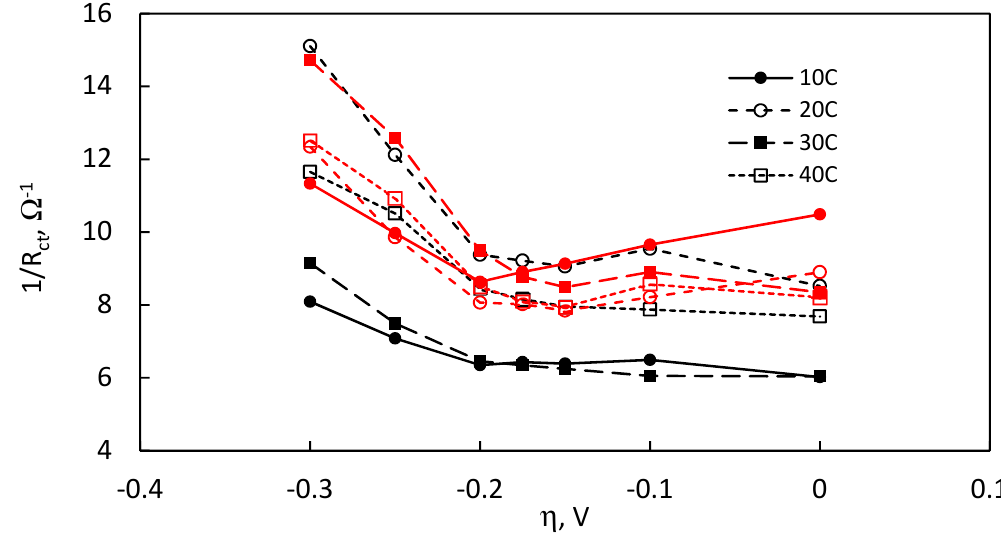
Figure 9. The dependence of 1 / R ct on overpotential. (Red lines correspond to samples, deposited with NaH 2 PO 2 ).